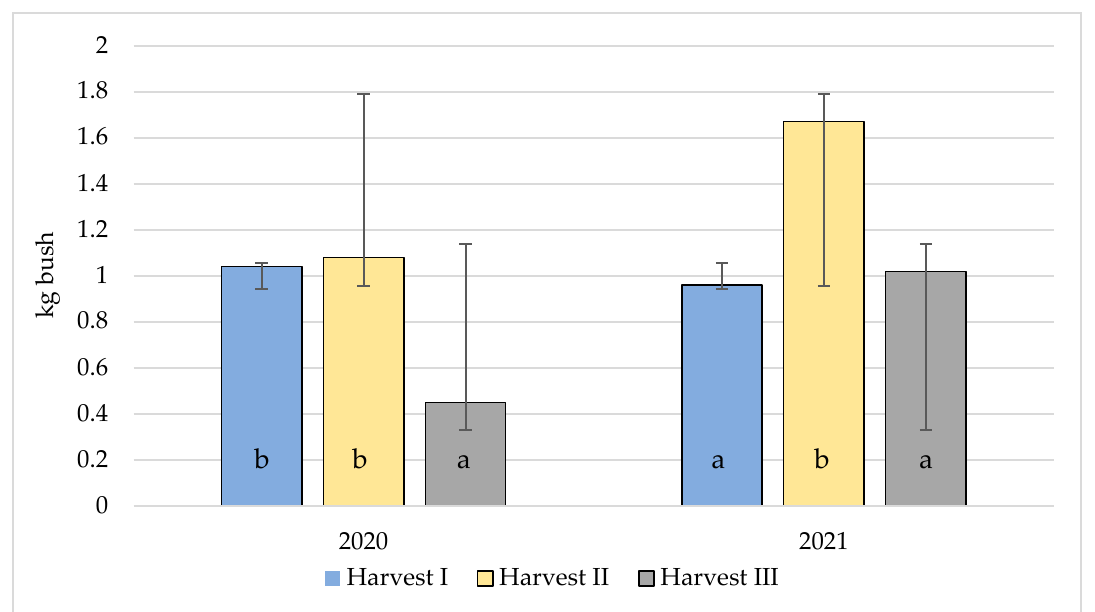
Figure 3. Impact of harvest time on the yielding of highbush blueberry bushes (kg bush) in 2020 and 2021 (harvest I—end of July; harvest II—beginning of August; harvest III—mid-August). The mean values marked with the same letters did not differ significantly at a = 0.05. Table 11. Impact of harvest time on highbush blueberry fruit weight and their biometric parameters in 2020 and 2021.